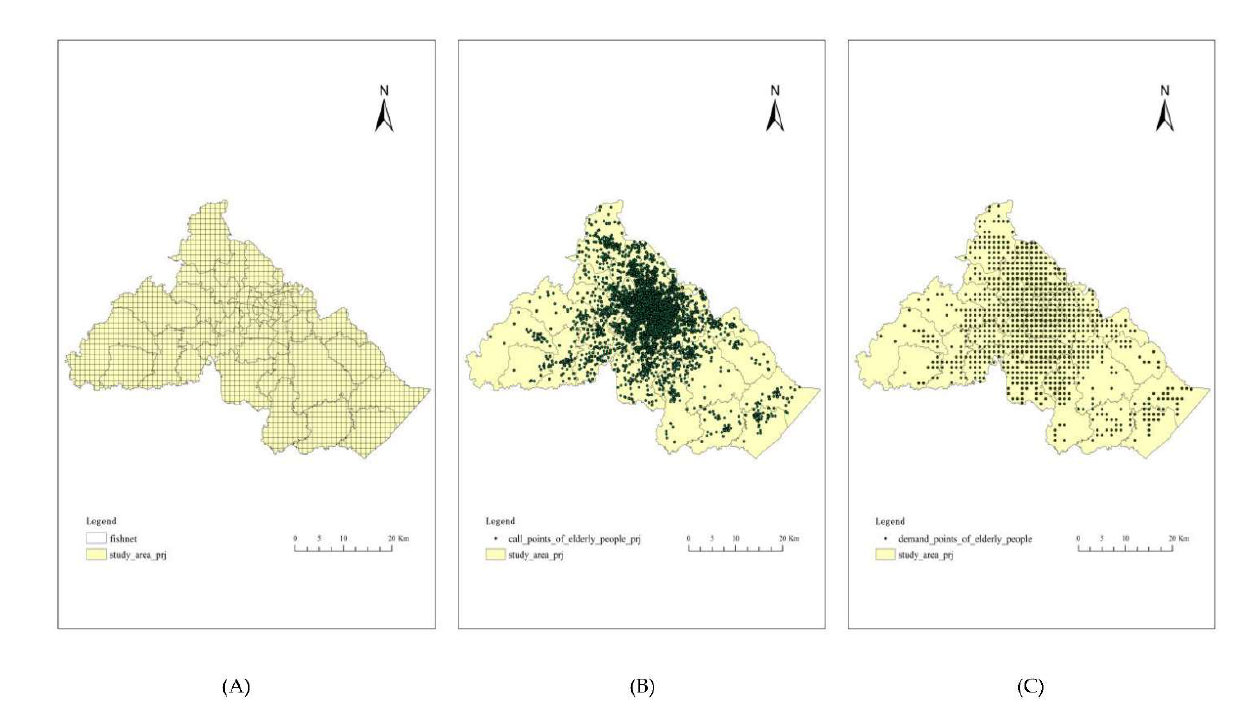
Figure 4. ( A ) Fishnet of study area; ( B ) EMS call points of the elderly; ( C ) Demand points of the elderly.